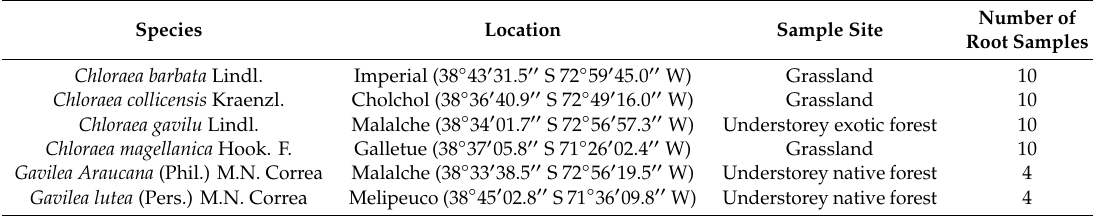
Number of Root Samples